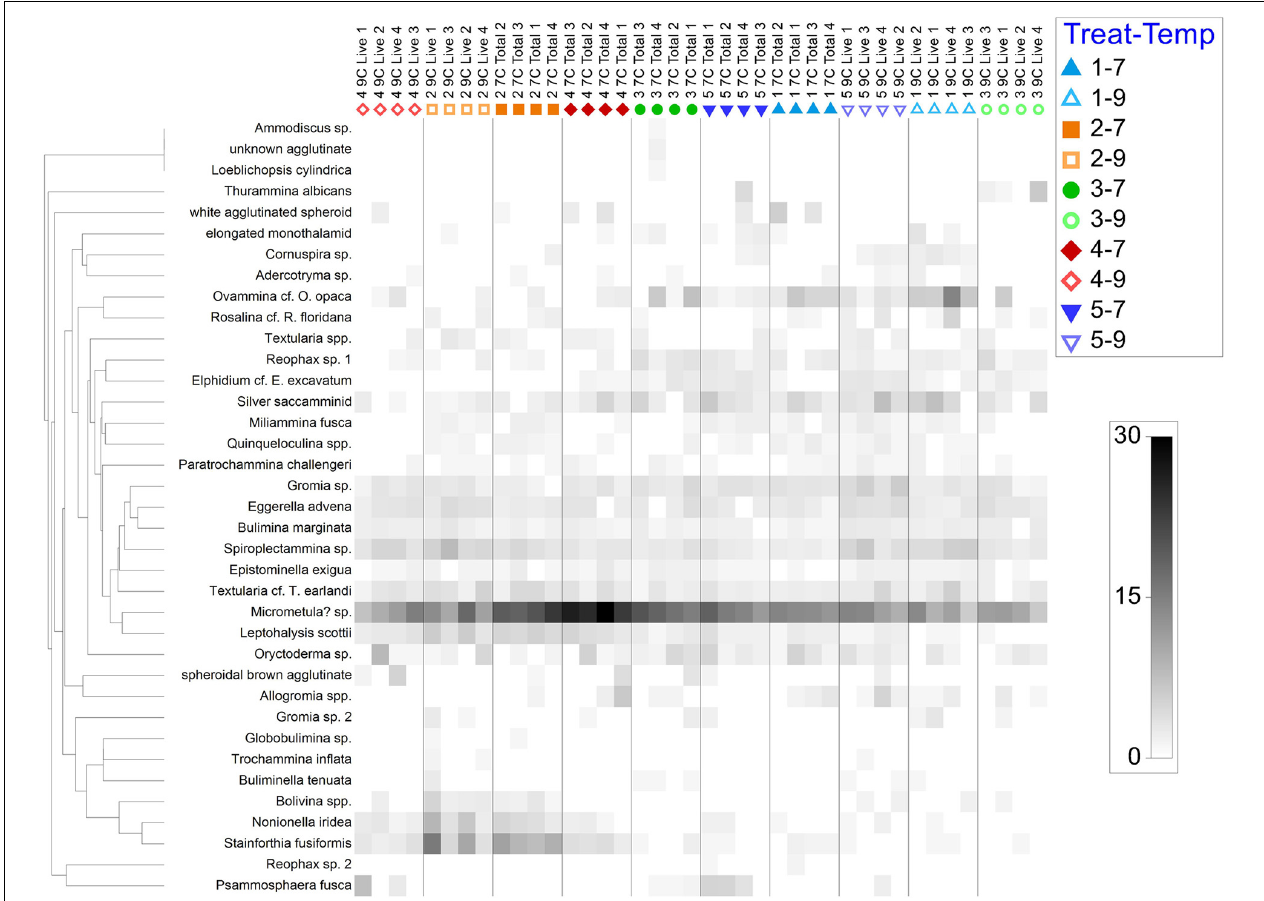
FIGURE 5 | Shade plot of square-root transformed data, by species and arranged by sub-treatment (i.e., treatment and temperature). Treatment 1 (blue) is Present Day; Treatment 2 (orange) is Hypoxia; Treatment 3 (green) is OA; Treatment 4 (red) is OA + Hypoxia; Treatment 5 (purple) is Pre-industrial. Filled symbols represent 7 ◦ C samples; open symbols represent 9 ◦ C